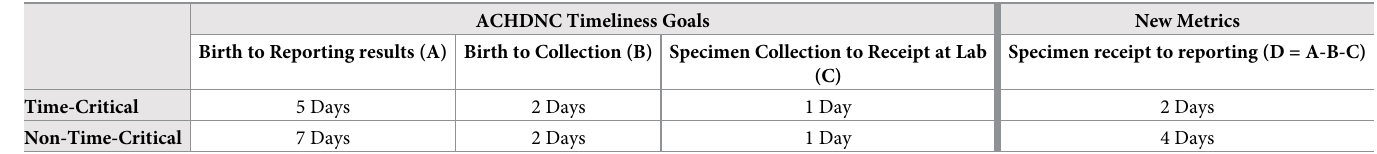
Table 3. New metric added to calculate time elapsed from specimen receipt at the NBS laboratory to reporting